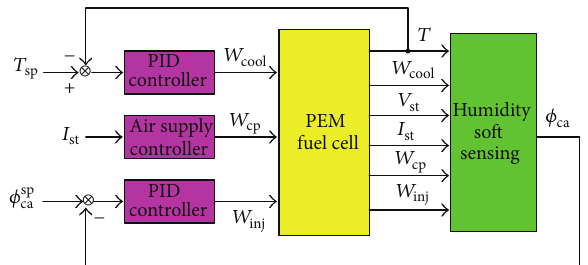
Figure 5: The schematic diagram of the relative humidity’s soft sensor.